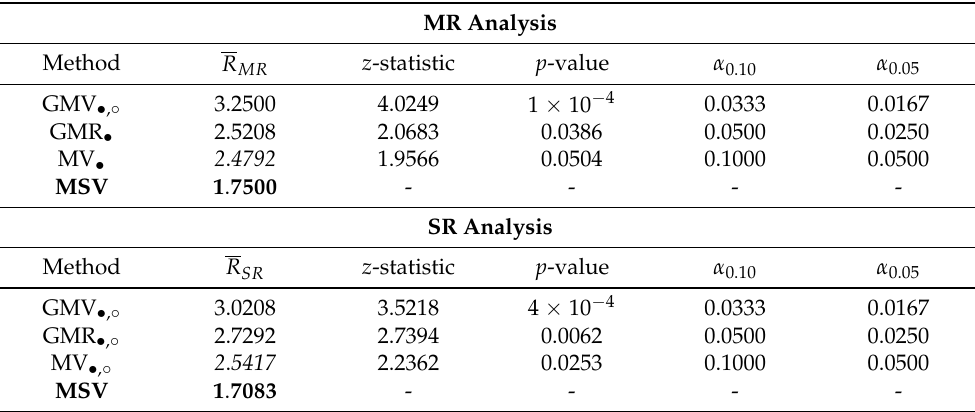
Table 3. Statistical results for the Holm test for α = 0.10 and α = 0.05 using the mean squared variance (MSV) strategy as the control method: mean MR and SR ranking of the strategies implemented ( R MR and R SR ), z -statistics and p -values of the Holm tests for the MR and SR analysis and adjusted α Holm values ( α 0.10 and α 0.05 ). The best results are in bold face and second-best results in italics. MR